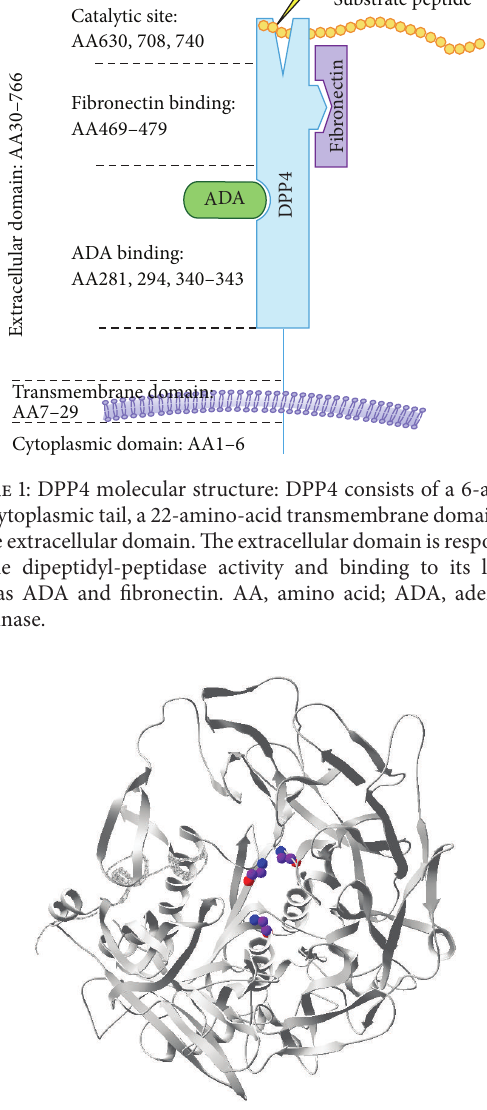
Figure 2: Catalytic triad of DPP4: backbone of residues that consist of DPP4 catalytic triad (Ser630, Asp708, and Hsp740) is shown (Purple: C; Blue: N; Red: